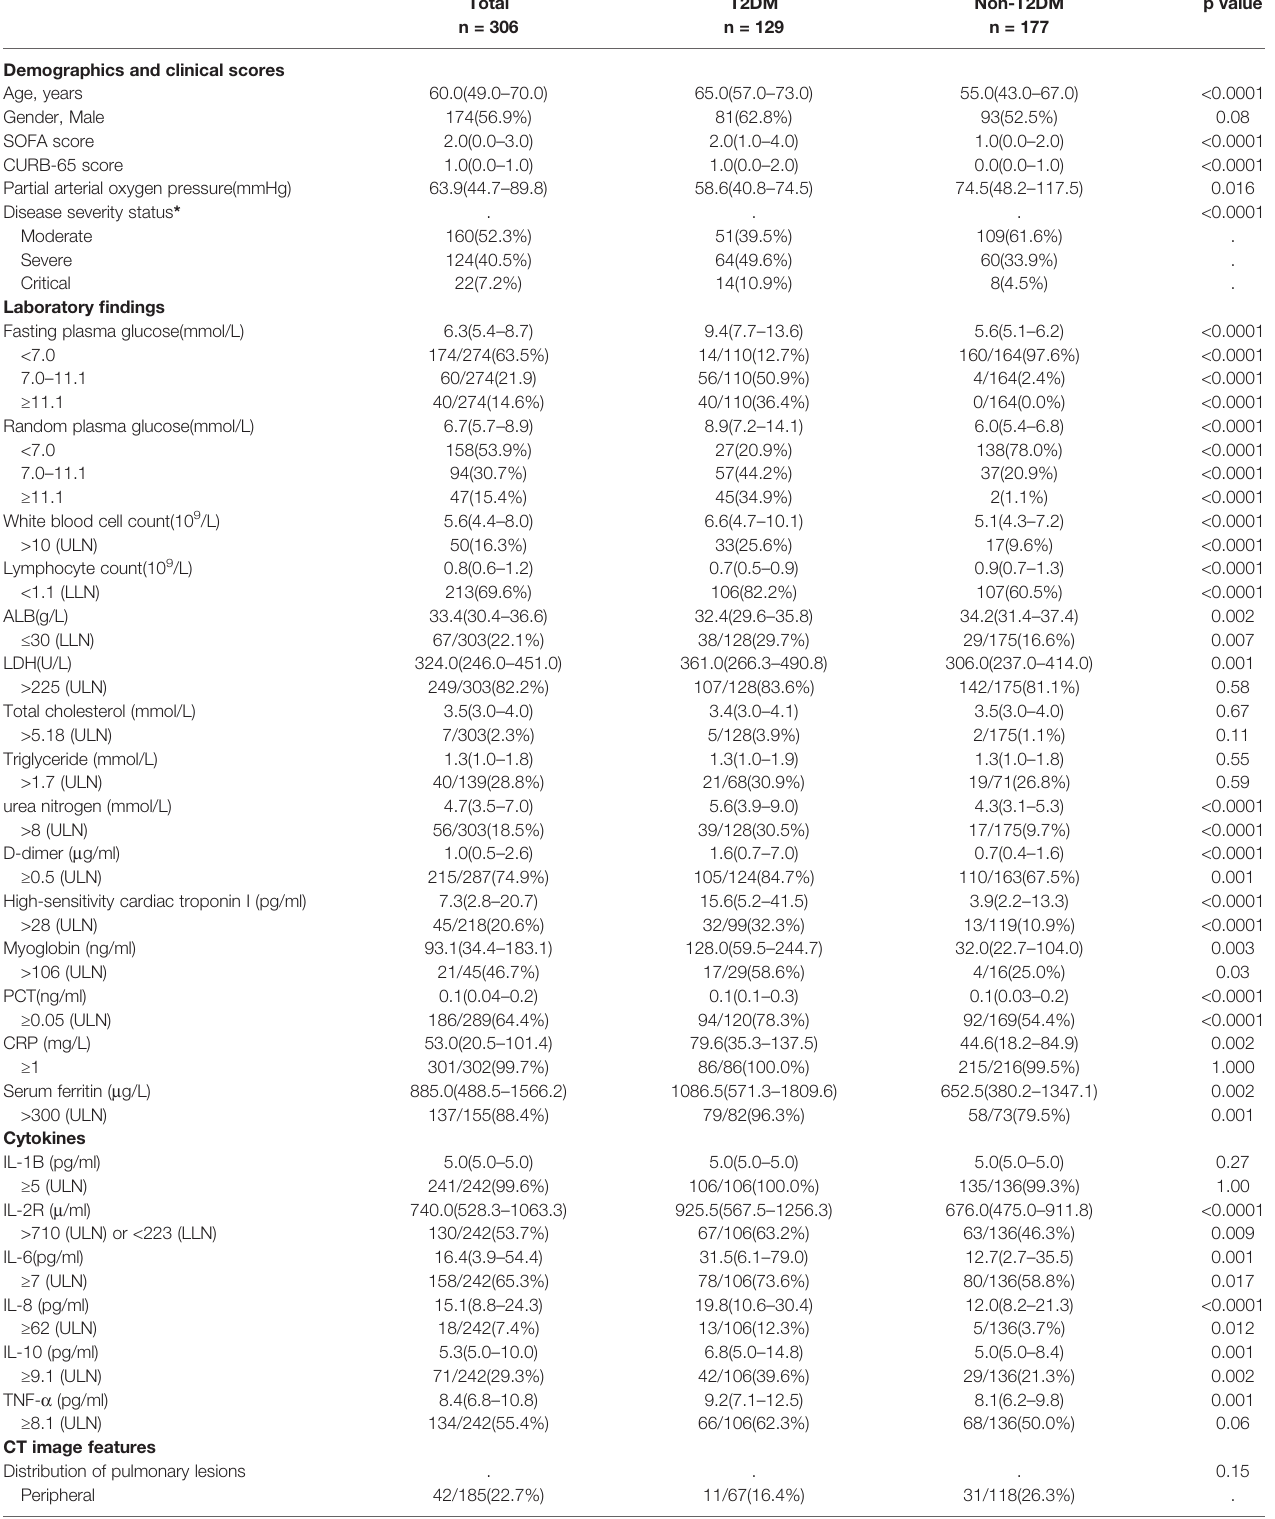
TABLE 1 | Comparing demographics, clinical scores, laboratory fi ndings, and CT image features on admission between T2DM and non-T2DM cases among COVID-19 patients. Total